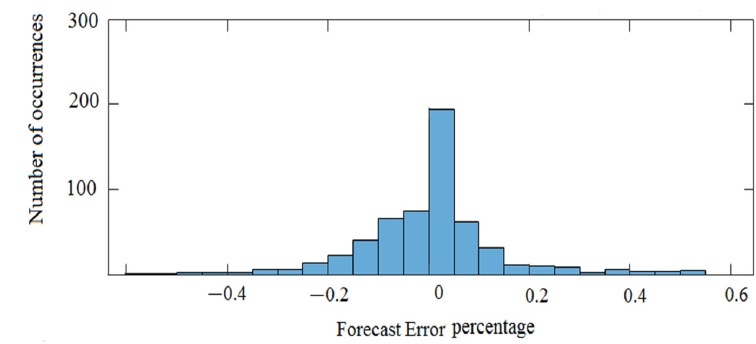
Figure 21. Illustration of prediction error in a histogram distribution.